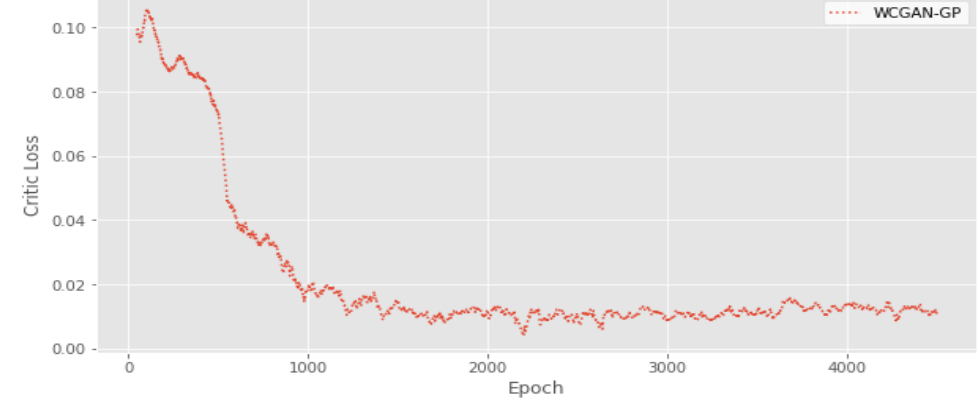
Figure 5. Difference between generated and real data critic loss.